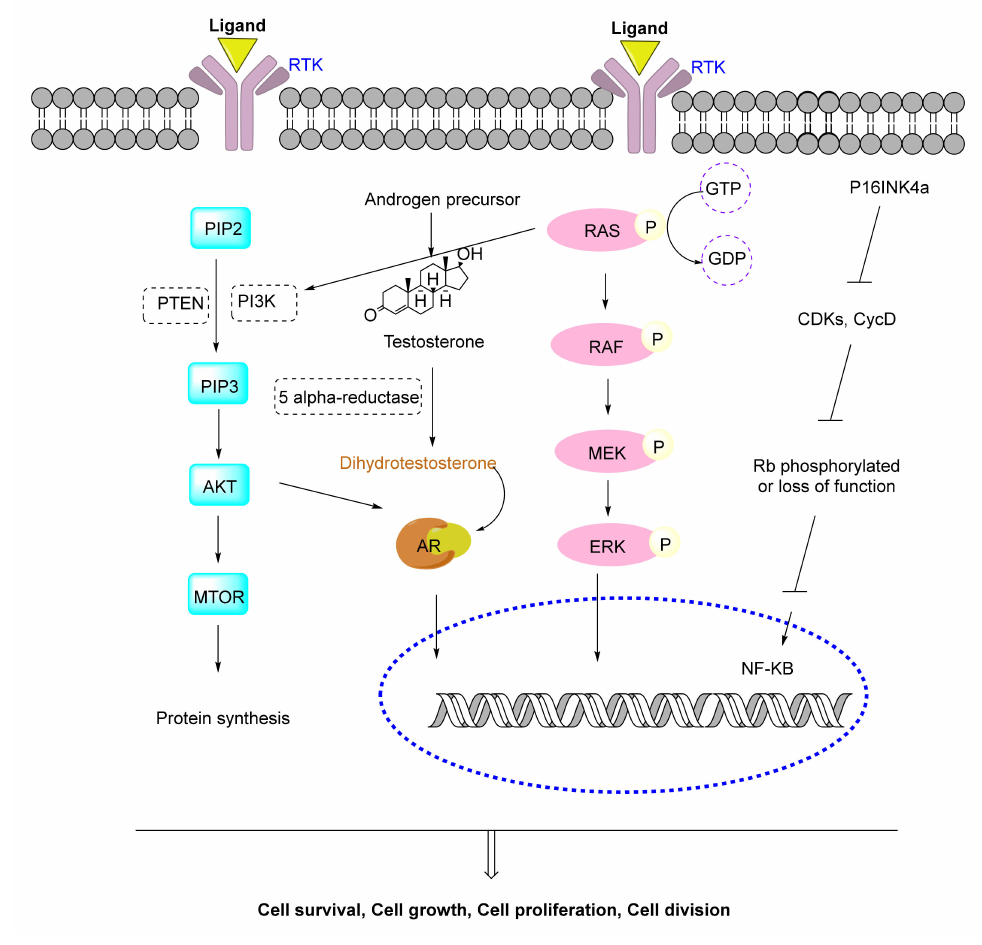
Figure 2. Schematic of some of the molecular pathways related to prostate